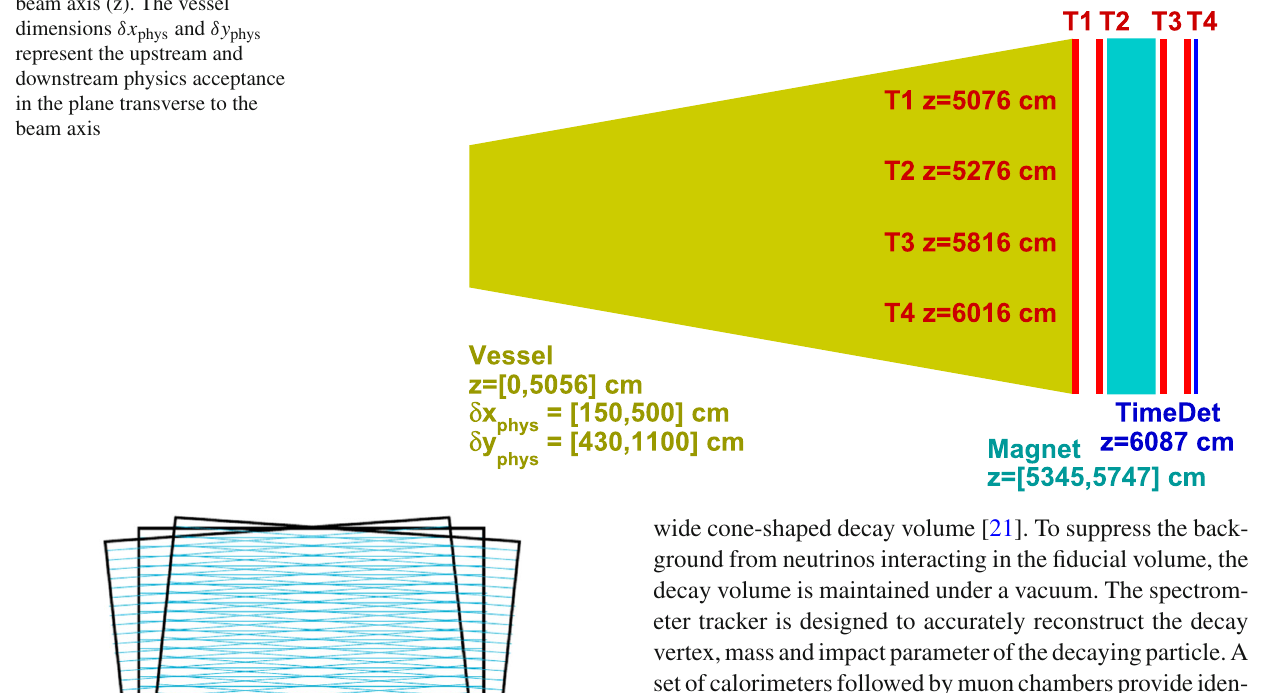
Fig. 1 Positions of the vessel and tracking stations along the beam axis (z). The vessel dimensions δ x phys and δ y phys represent the upstream and downstream physics acceptance